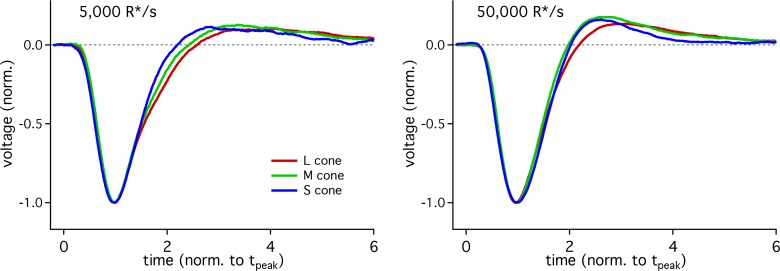
S and LM cones have similar response shapes Left and right panels superimpose average responses from each cone type with the peak absolute amplitude and the time to peak normalized to one.With this normalization, the responses of different cone types are quite similar. Hence, the differences in kinetics illustrated in Figures 1 and 2 are not due to a preferential slowing of either the rising or falling phase of the response (see Discussion).